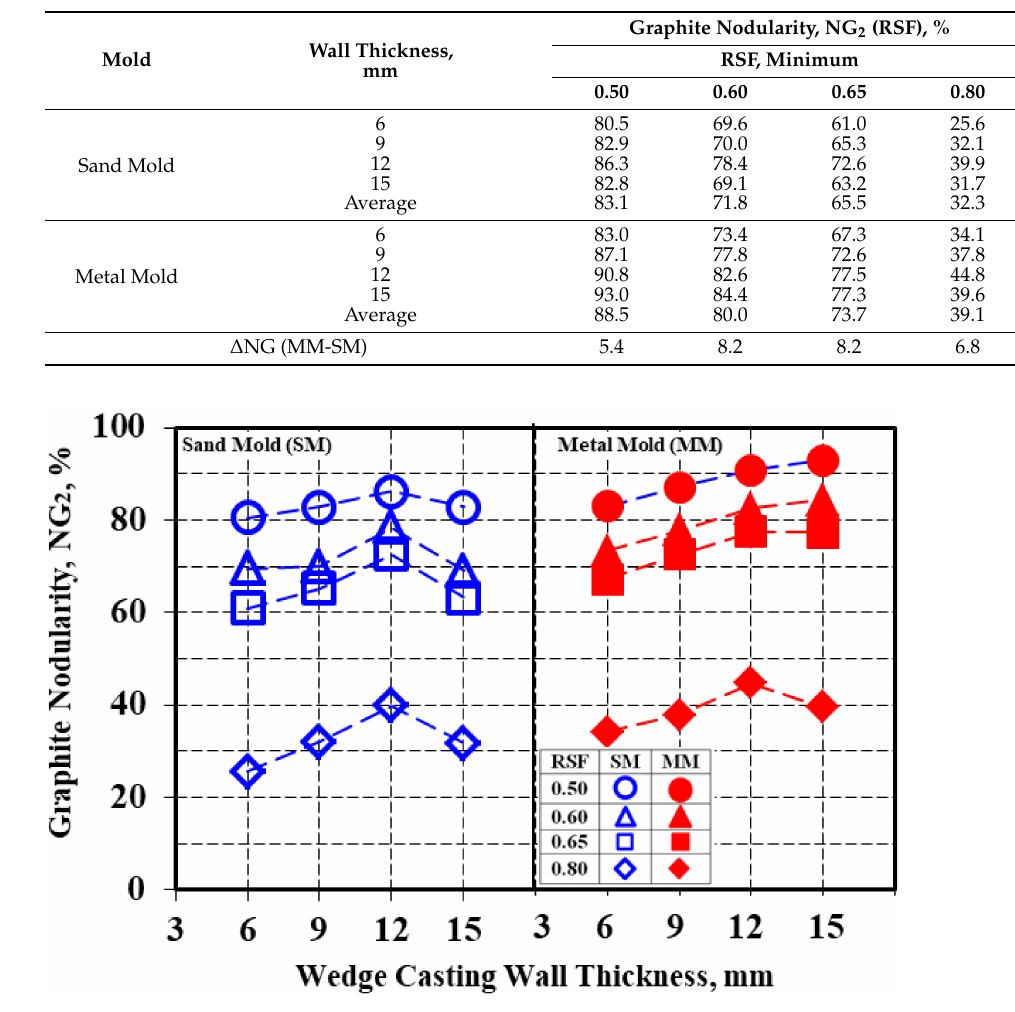
Figure 13. Graphite nodularity (NG 2 ) as a function of the mold media and wedge casting wall thickness for imposed minimum values for